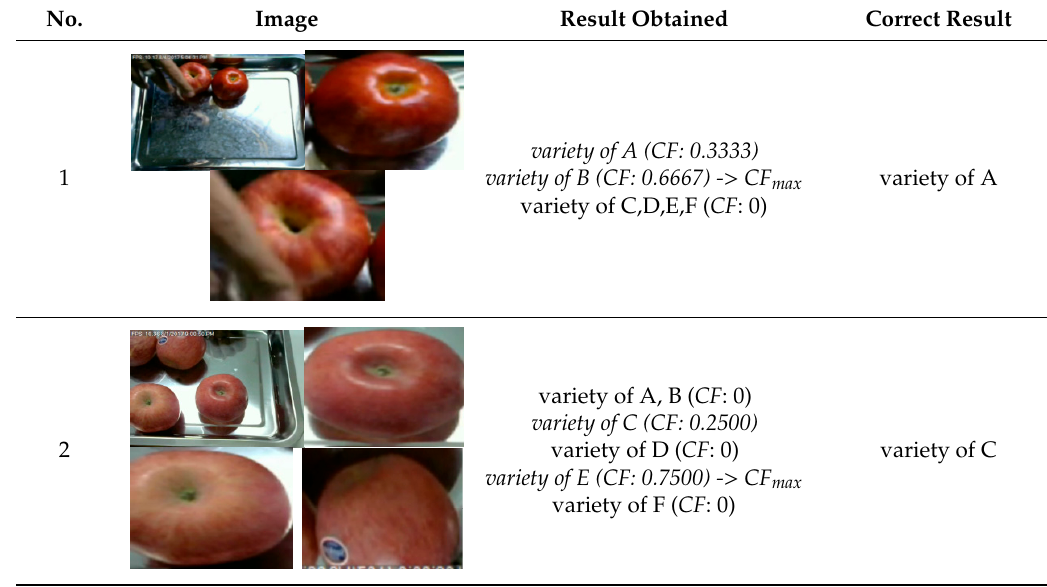
Table 7. Results of apple variety classification using the proposed method.